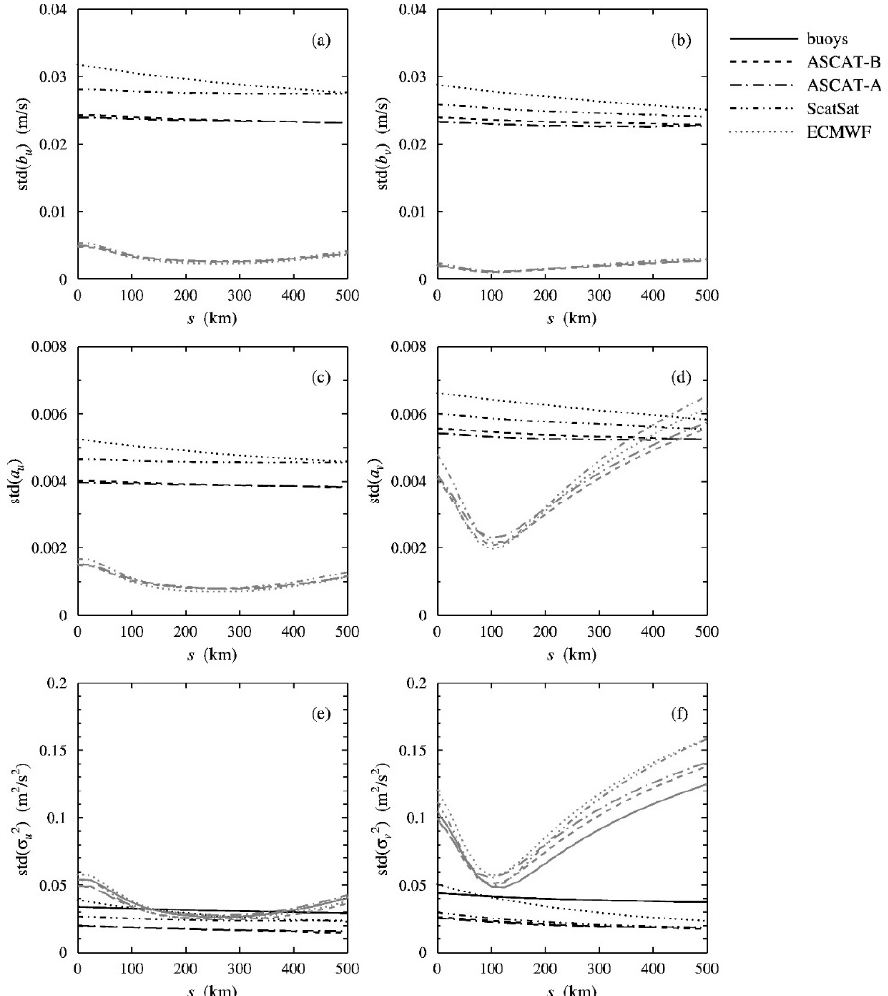
Figure 3. Quintuple collocation results for the accuracy (black curves) and the model spread (gray curves) as a function of the scale at which the representativeness errors are evaluated for the calibration biases for u ( a ), the calibration biases for v ( b ), the calibration scalings for u ( c ), the calibration scalings for v ( d ), the error variances for u ( e ), and the error variances for v ( f ).